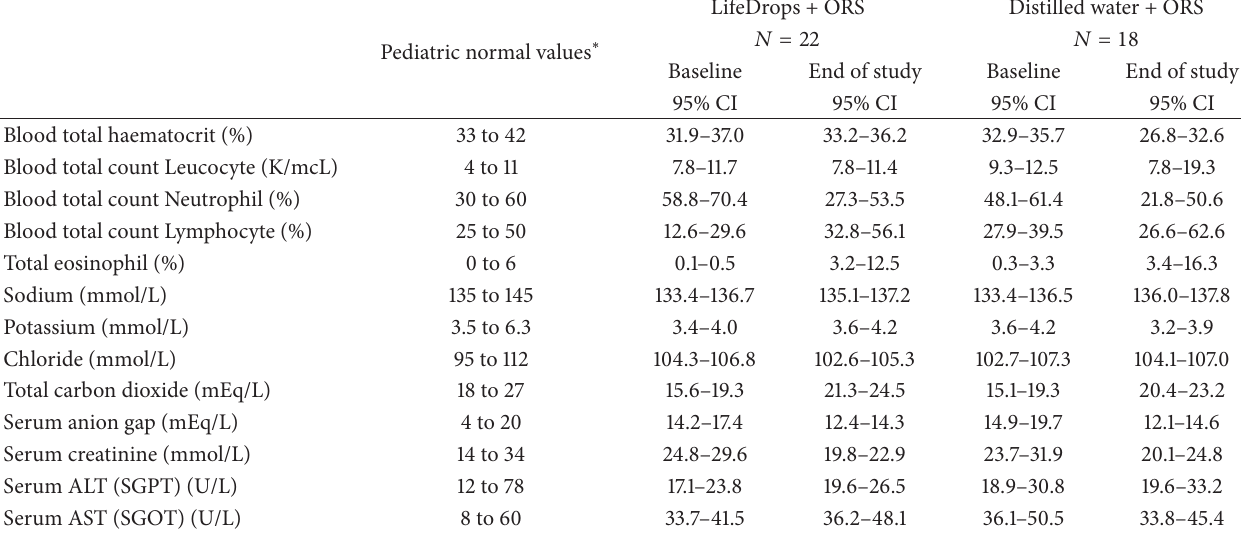
Table 7: Results from testing of blood samples for various factors in patients aged 2 to 5